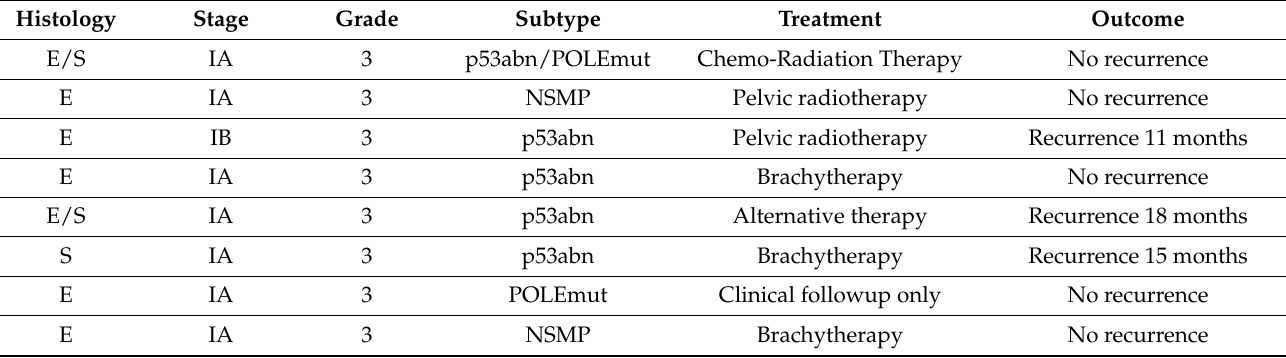
Table 2. Molecular profile of high-risk EC (FIGO low stage, high grade).